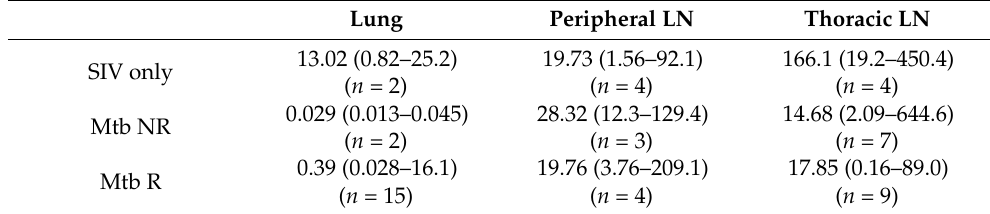
Table 2. Median RNA copy numbers (RNA copies × 10 6 /g tissue (lower–upper range)) are shown for each tissue type from the three cohorts. n = the number of